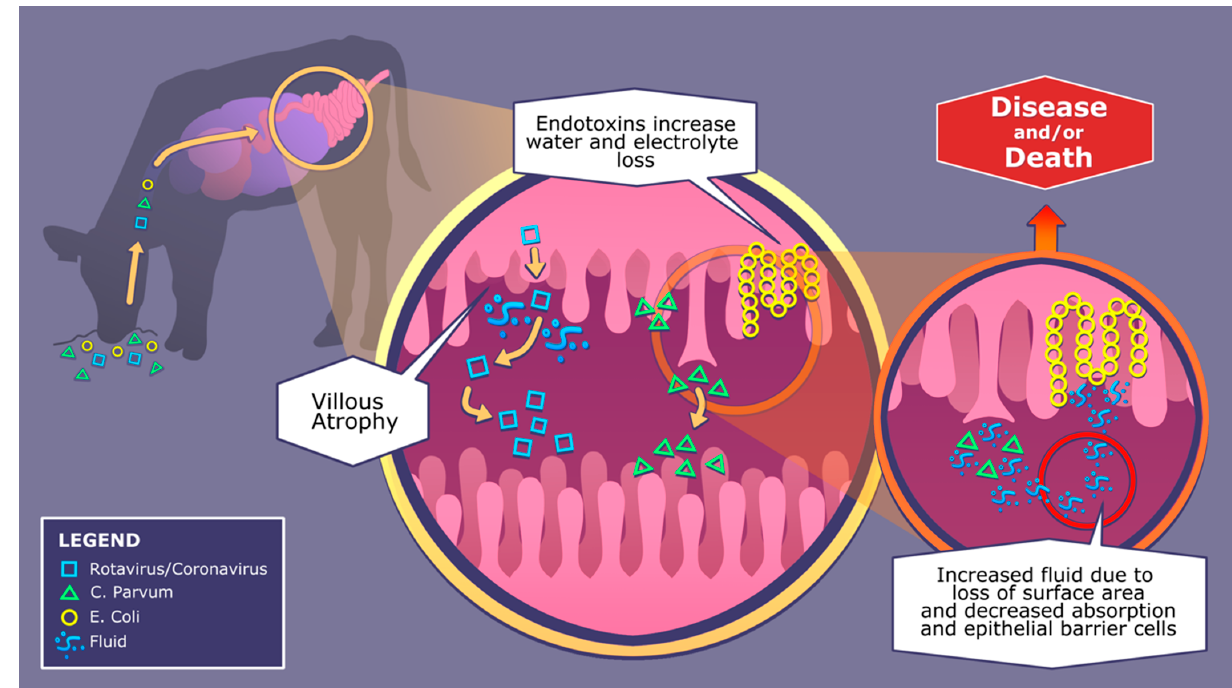
Figure 1. Pathophysiology of diarrhea-causing pathogens; rotavirus, coronavirus, C. parvum and E. coli.